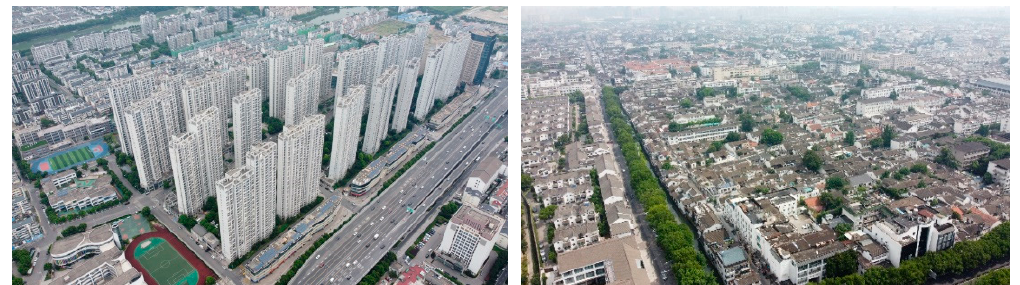
Figure 5. Aerial view of Nanhuan ( left ) and Daoqian ( right ). Table 2. Community construction index.